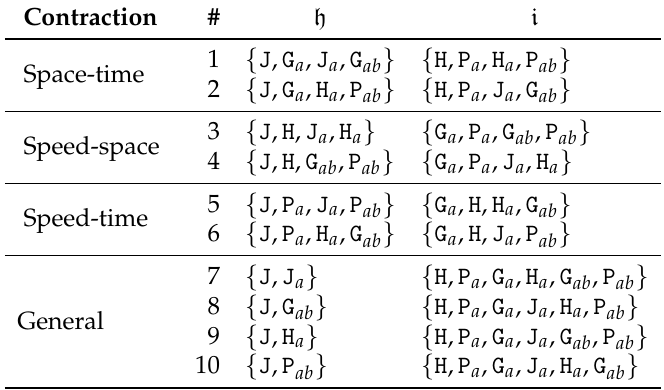
Table 3. The contractions to the kinematical higher spin algebras. They can be summarized again as a (higher spin) cube; see Figure